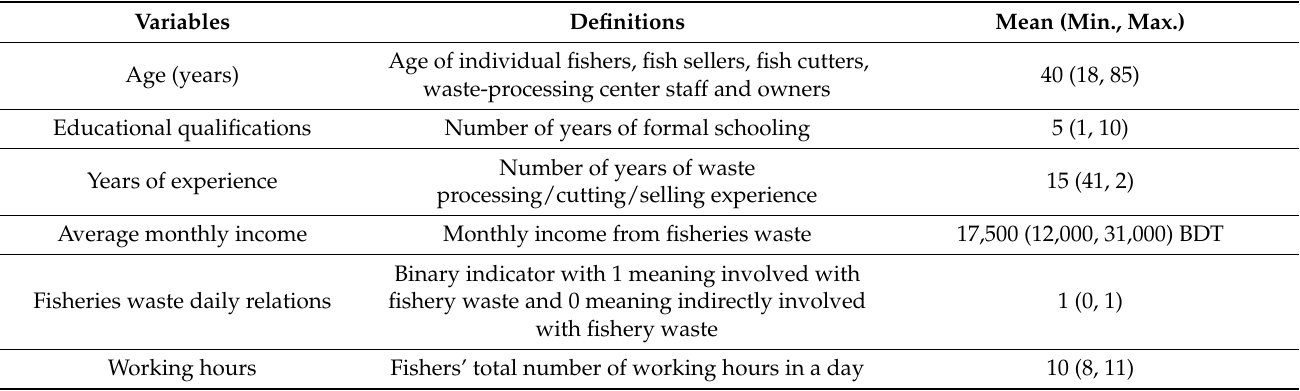
Table 2. Socio-economic profile of the